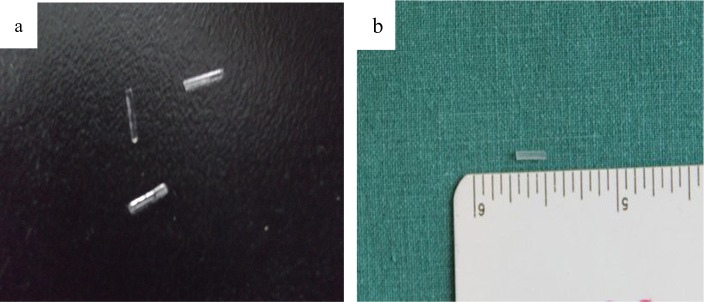
Silicone 125I seeds, the diameter and length was 0.8 mm by 4.5 mm.